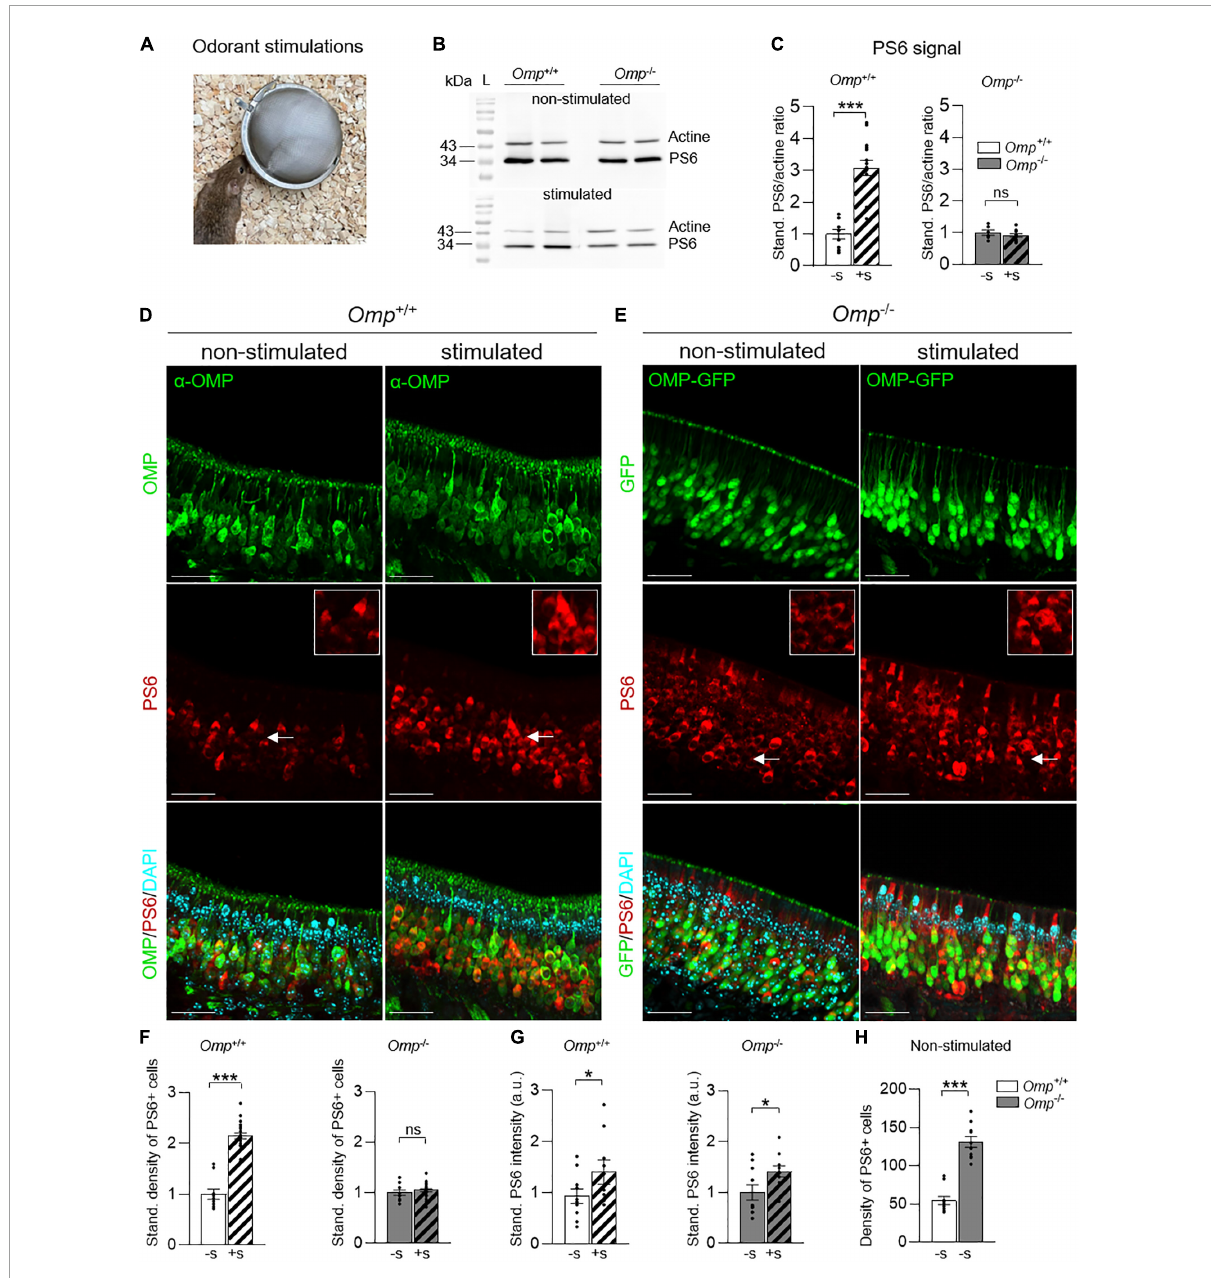
FIGURE2 Increased basal activity of MOE neurons in OMP null mice. (A) Odorant stimulations are performed by using odorant solutions (Cinnamon 10% or Cocoa 20%) or the odorless water, during 1 h. (B) Western blot of phosphoserine 6 (PS6). At 32 kDa, the bands represent the PS6 expression and at 43 kDa, the actine expression (control). The results show the intensity difference of PS6/actine in Omp + / + and Omp − / − mice in stimulated (here, with Cinnamon) and non-stimulated conditions (water). L, ladder. (C) Western blot analysis of the PS6 signal in the MOE of Omp + / + and Omp − / − mice with (+S; dashed bars) or without (–S; solid bars) odorant stimulation (obtained from Cinnamon and Cocoa extracts) showing the PS6/actine standardized ratio. N = 5–9 animals were used per genotype and condition (B,C) . (D,E) PS6 immunostainings in the MOE of Omp + / + (D) and Omp − / − (E) with or without odorant stimulation. In red, the staining of PS6 shows the activated neurons. In green, the staining of mature olfactory sensory neurons. In blue, the nuclei stained with DAPI. Insets show OSNs details indicated by white arrows on main pictures. Scale bars: 30 µ m. (F) Odorant stimulation (+S; here, with Cinnamon) induces a significant increase of activated neurons in Omp + / + but not in Omp − / − mice. (G) PS6 staining intensity is increased significantly in the stimulated condition compared to the non-stimulated condition for both the Omp + / + and Omp − / − mice. Dot-plots representation in panels (F,G) are standardized to the non-stimulated condition − S. (H) Spontaneous basal neuronal activity is increased in Omp − / − mice as shown by the density of the observed PS6 positive cells [insets in panels (D,E) ]. N = 5 animals were used per genotype and condition. Values obtained are represented as mean ± SEM. For comparisons between conditions and between genotypes, one-tailed or two-tailed Student’s t -tests/Wilcoxon w -tests are respectively used, * p < 0.05, *** p < 0.001 and ns for